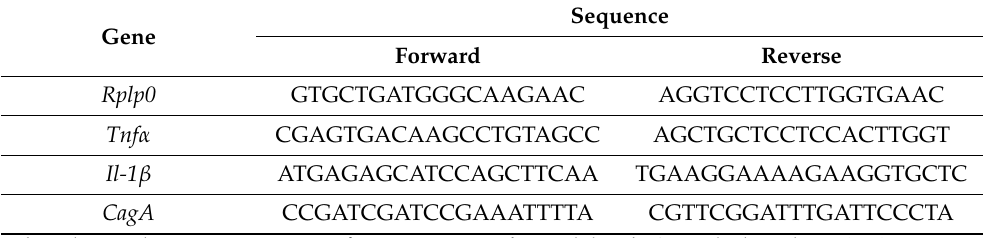
Table 1. Sequences of primers used for quantitative polymerase chain reaction. Gene